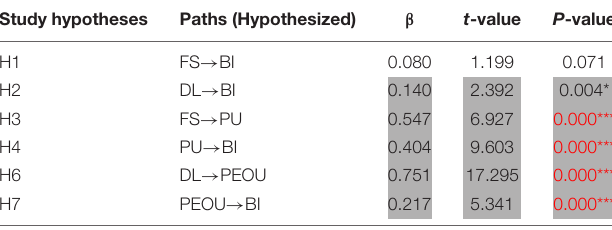
TABLE 3 | Factor loadings and validity of scales. TABLE 4 | SEM